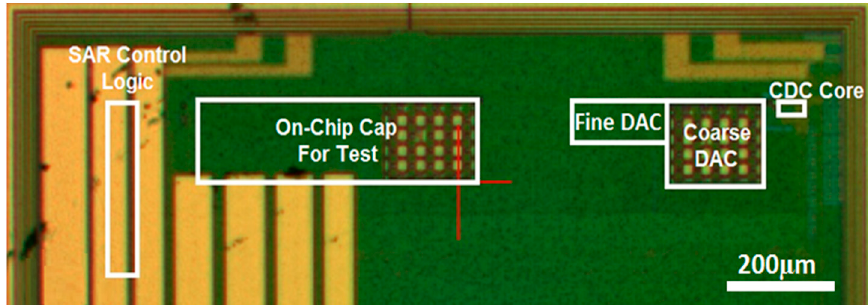
Figure 6. Chip photo of the prototype readout circuit in 0.18 μ m CMOS process.